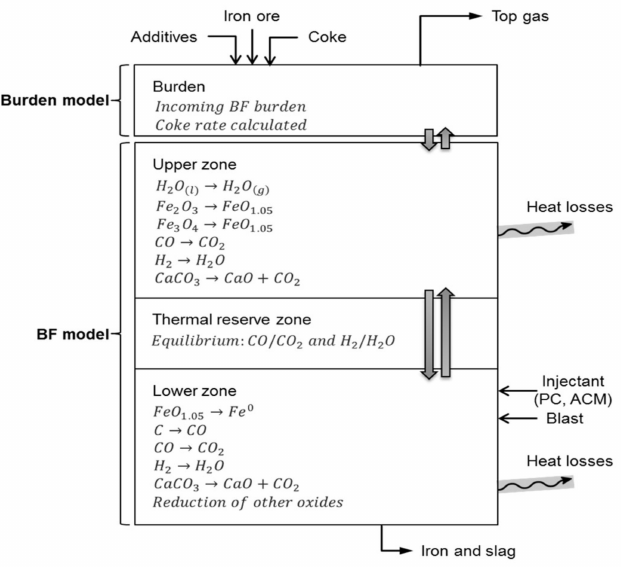
Figure 8. Blast furnace model, after